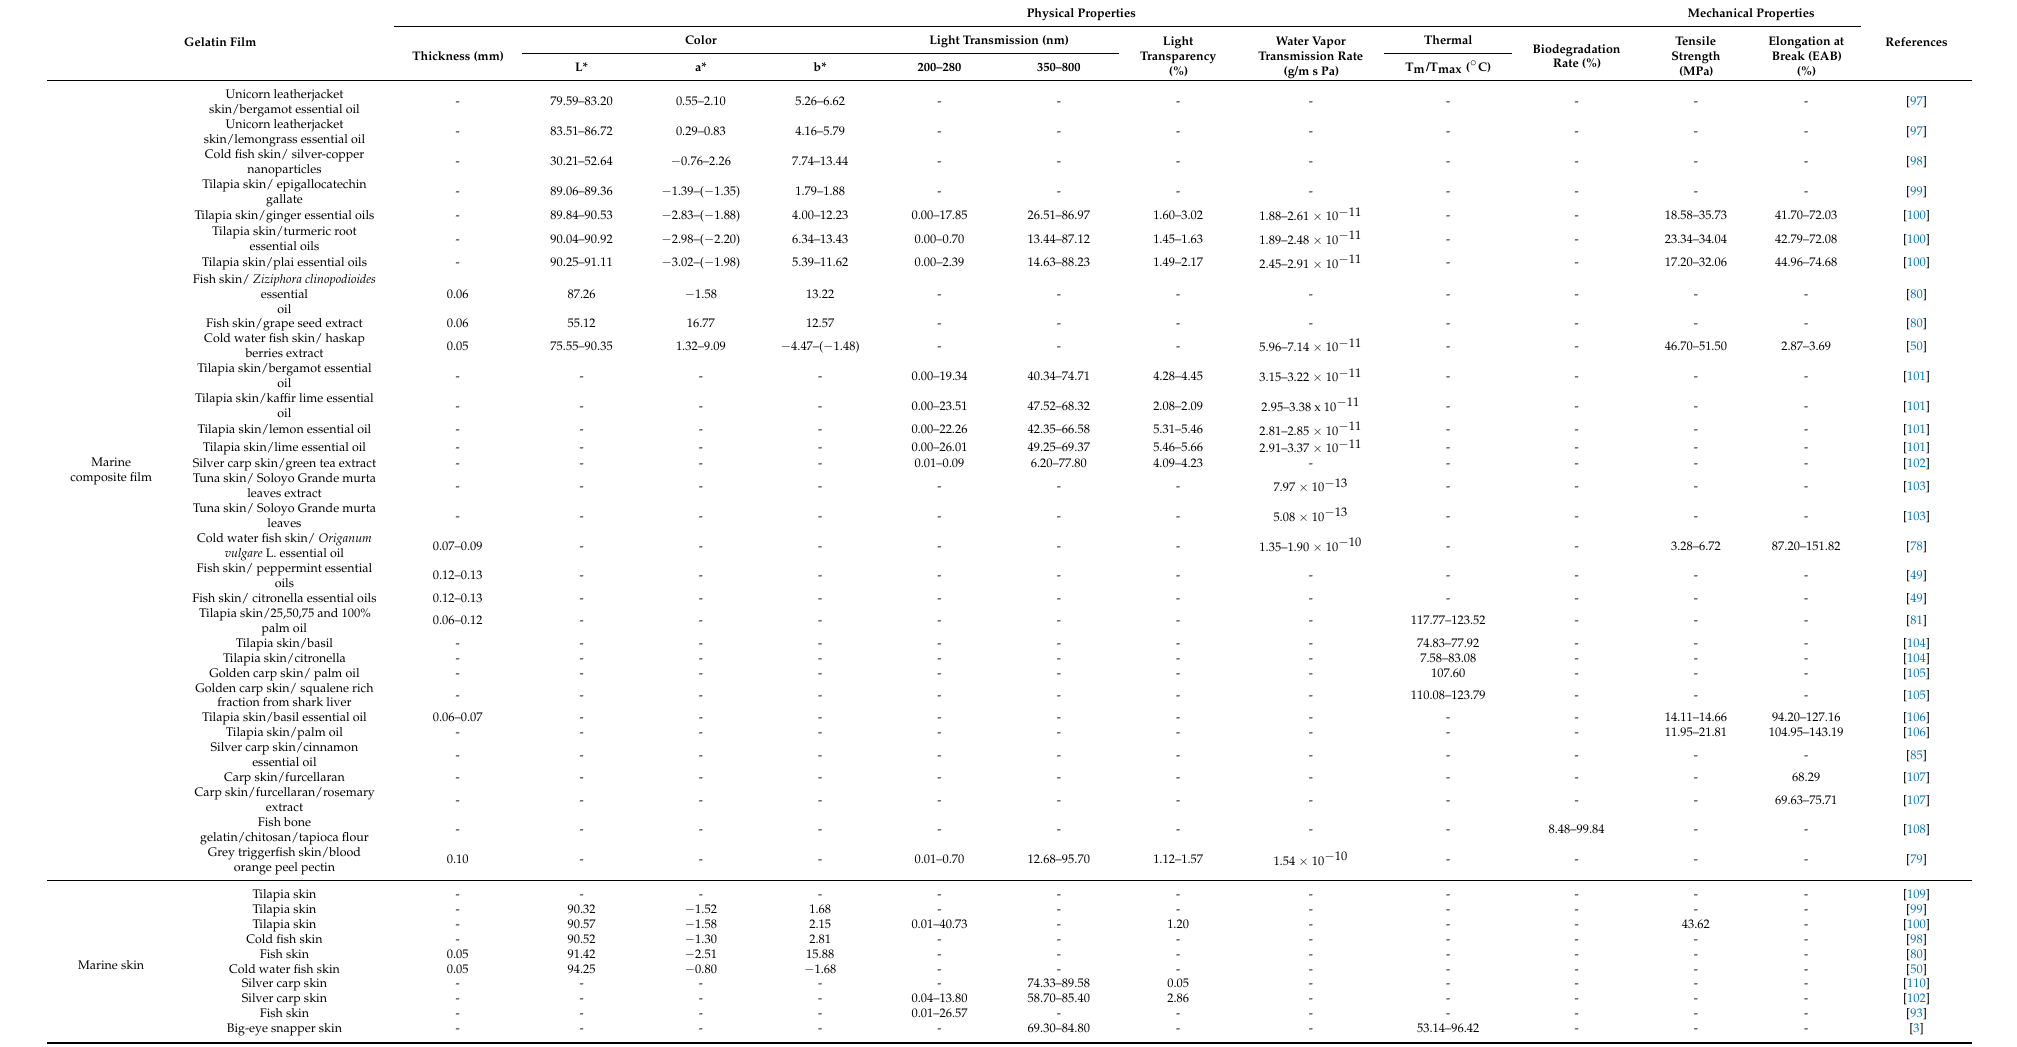
Table 2. Physical and mechanical properties of marine gelatin-based